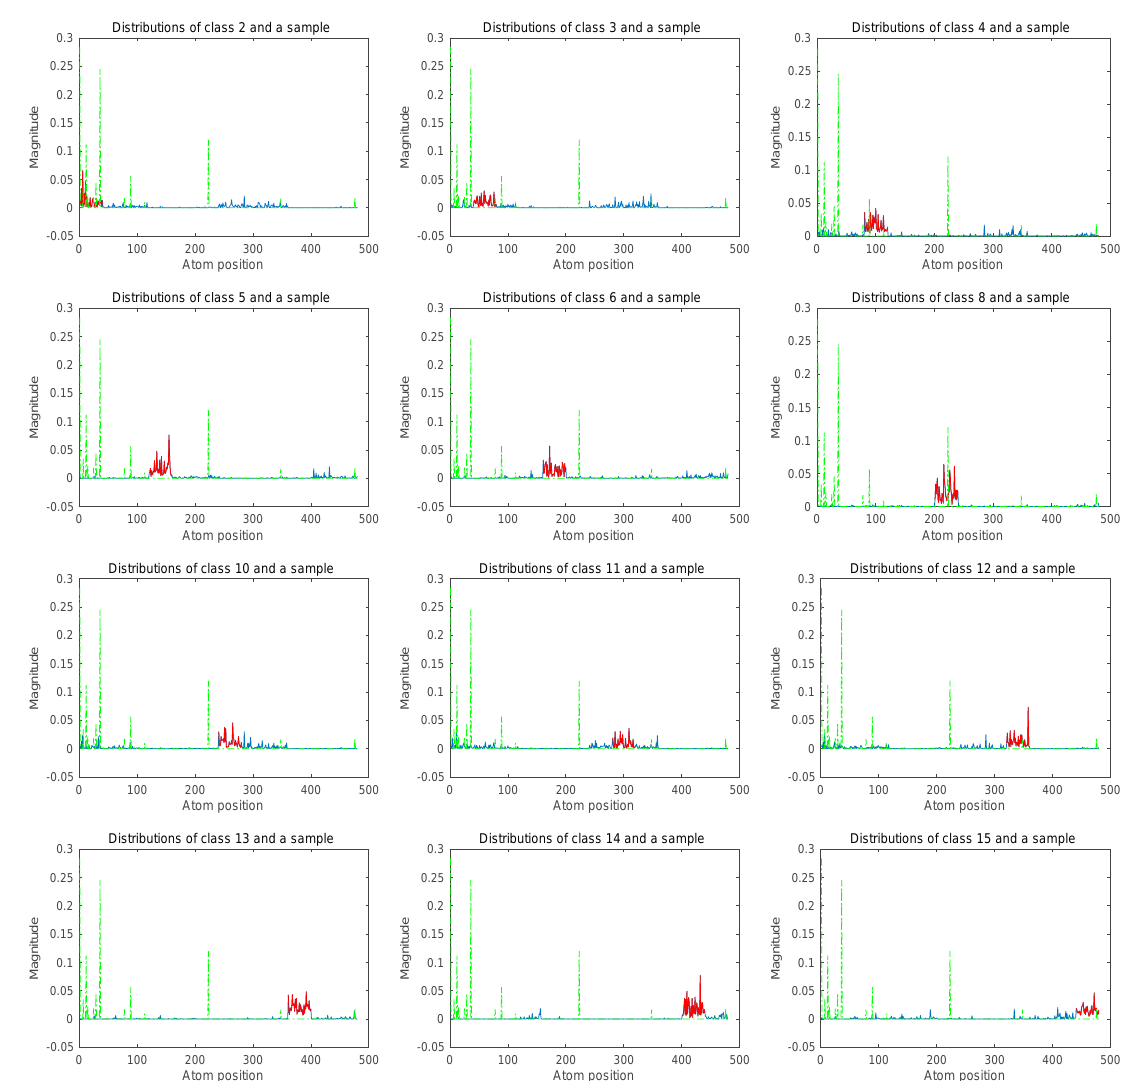
Figure 2. Distribution of sparse codes of samples (twelve classes and a test sample) in the Indian Pines image under a structural dictionary with 480 atoms in total. The red curve indicates the corresponding class-dependent atoms. The used test sample belongs to Class 2.